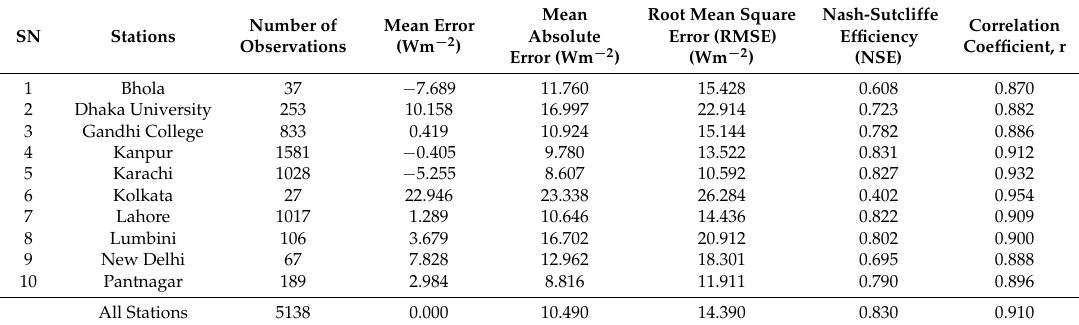
highest (26.284 Wm − 2 ) and that of Karachi is lowest (10.592 Wm − 2 ) among the stations in the IGP. Table 3. Results of the ADRF model using all AERONET stations in the IGP by using AERONET aerosol optical depth (AOD) and atmospheric water vapour at each station. Number of SN Stations